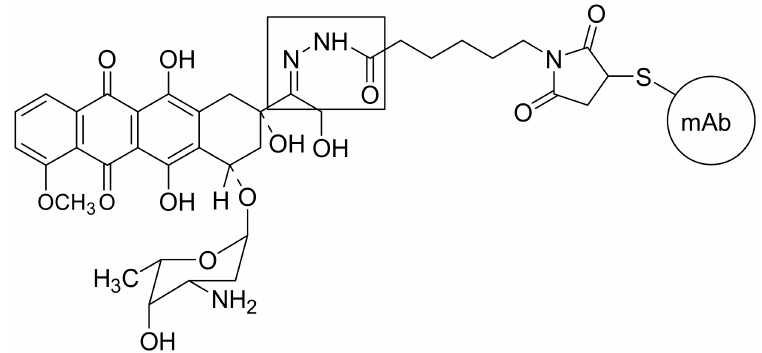
Figure 10. Structure of BRD96-doxorubicin